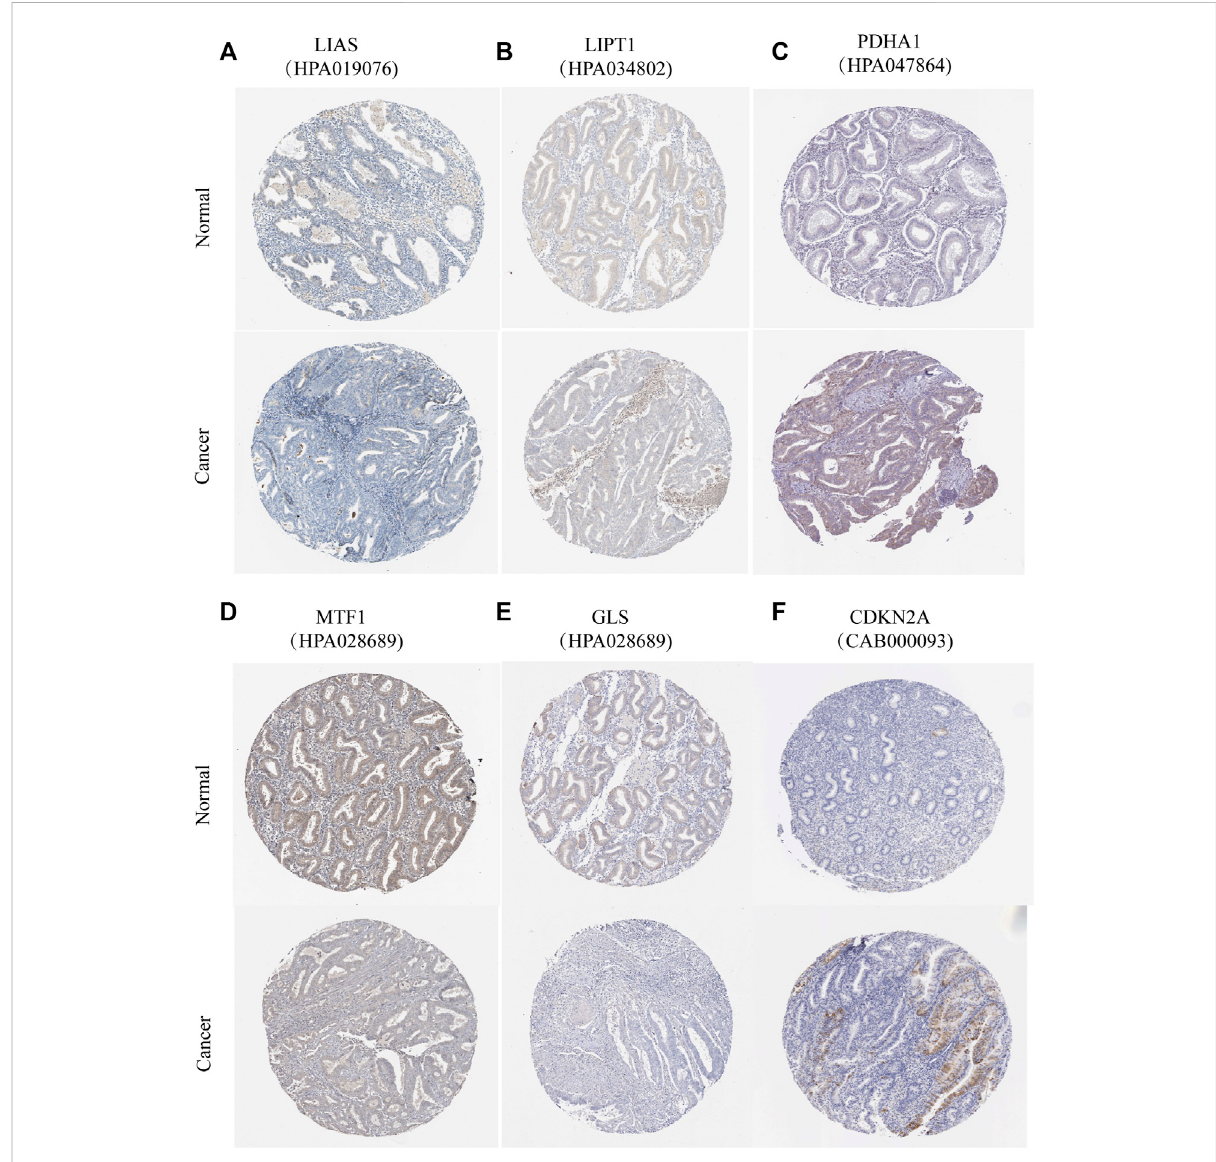
FIGURE 2 ProteinexpressionofsixCRGsintheHPAdatabase.Veri fi cationof (A) LIAS (B) LIPT1 (C) PDHA1 (D) MTF1 (E) GLS (F) CDKN2Aproteinexpression in normal and tumor tissue utilizing the Human Protein Atlas (HPA)